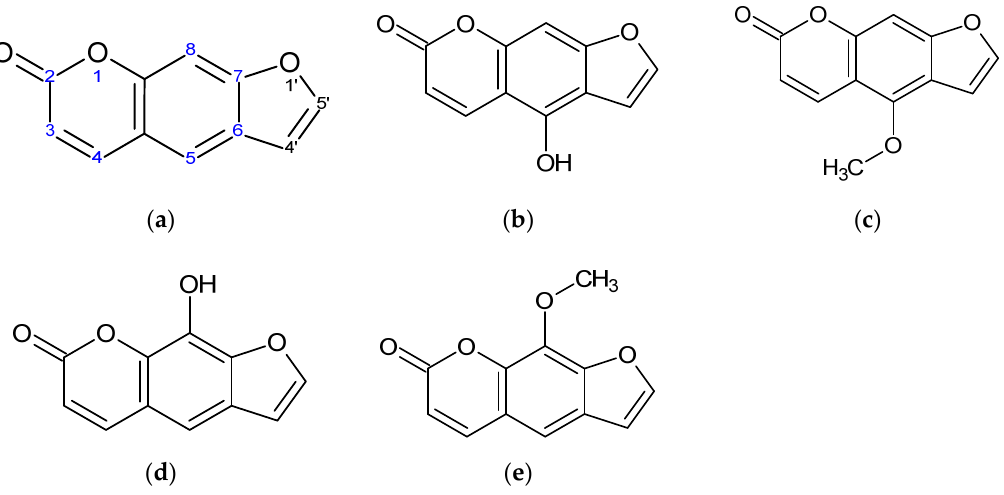
Figure 1. Structure of psoralen derivatives. ( a ) Psoralen, ( b ) 5-hydroxypsoralen (bergaptol), ( c ) 5-methoxypsoralen (bergapten), ( d ) 8-hydroxypsoralen (xanthotoxol), and ( e ) 8-methoxypsoralen (xanthotoxin).